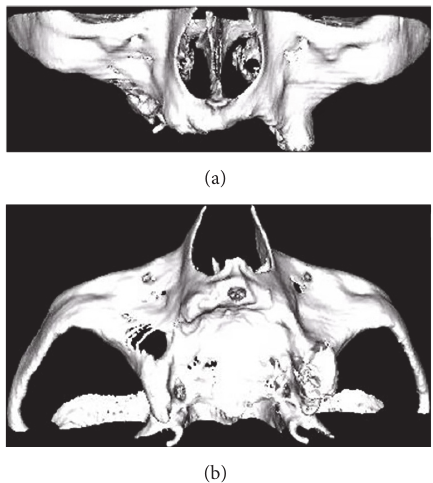
Figure 4: Maxilla 3D reconstruction in frontal (a) and occlusal view (b).